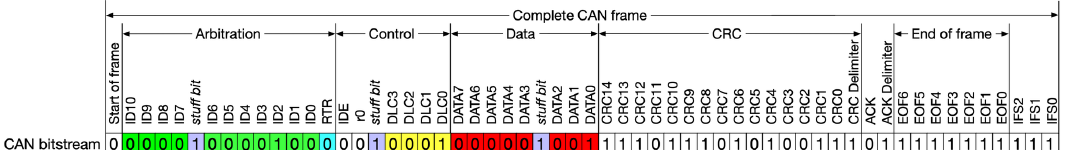
Figure 3. Example of CAN bus frame. Green bits make up the message ID field, yellow bits are DLC (data length code), red are data bits, violet are stuff bits. Image courtesy of Ken Tindell, Canis